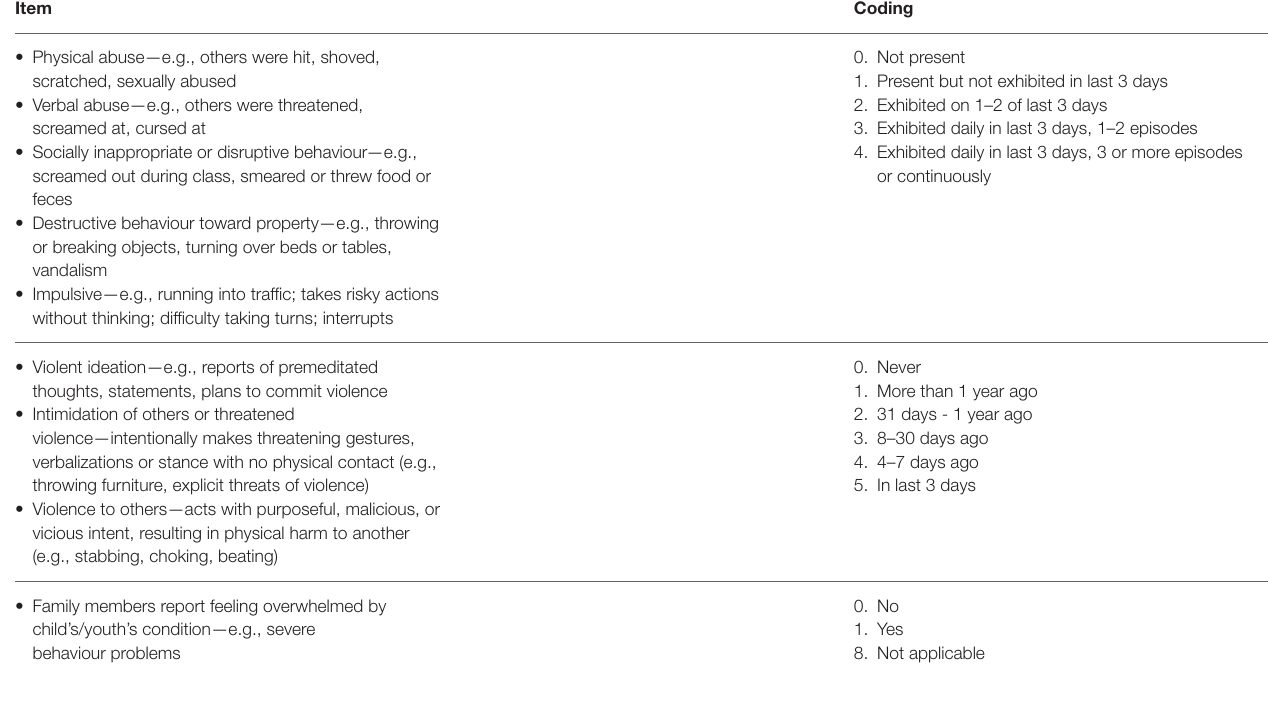
TABLE A1 | Items used in the RIO